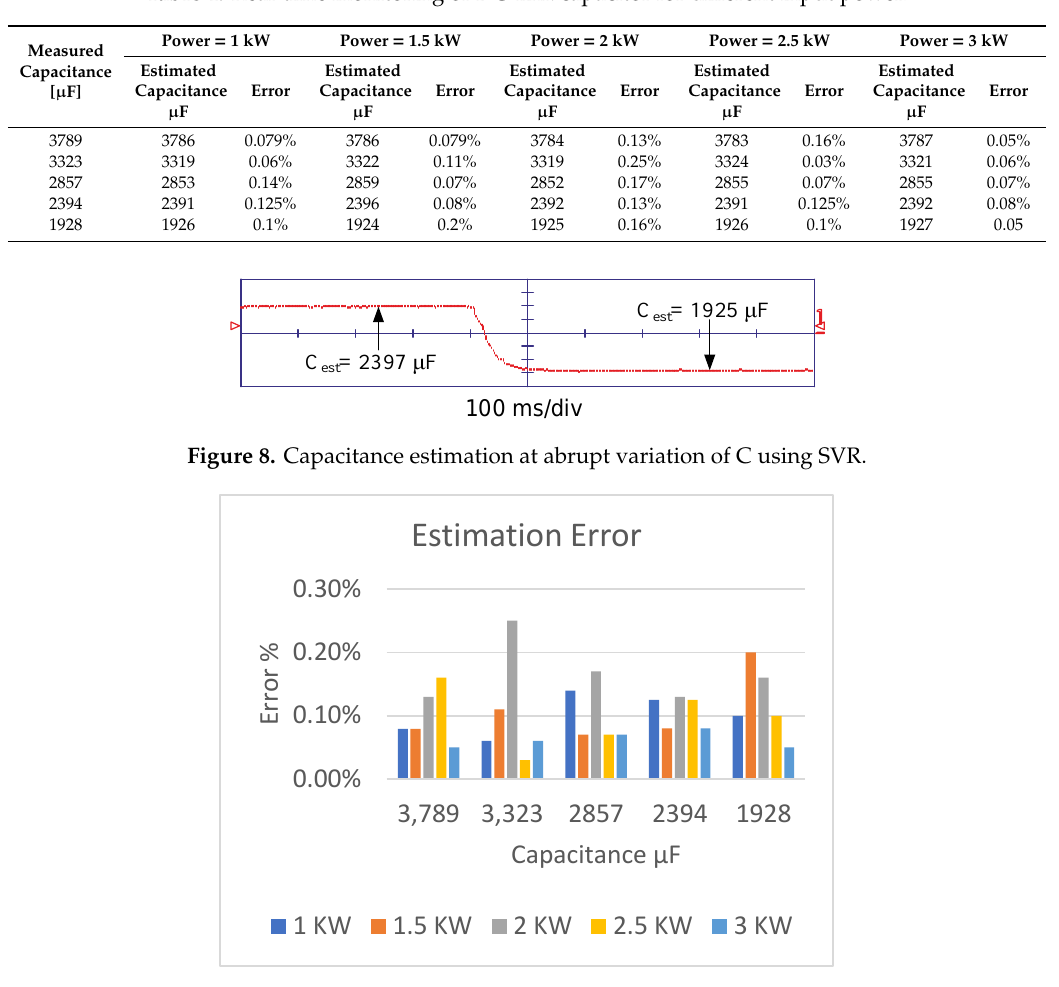
Figure 9. Capacitance estimation errors in di ff erent power. Table 5. Capacitance monitoring